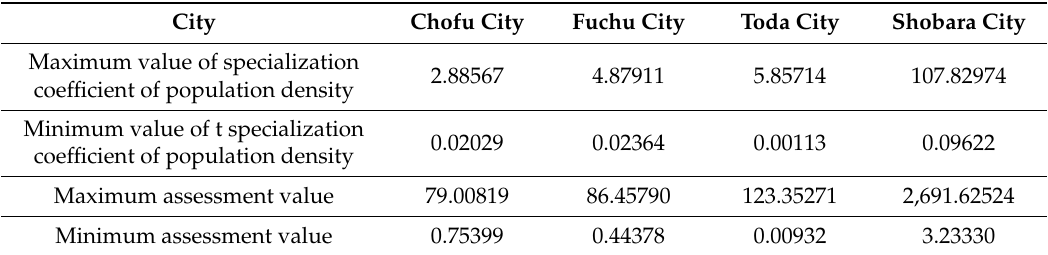
Table 8. Results with the specialization coe ffi cient of population density as a weighted coe ffi